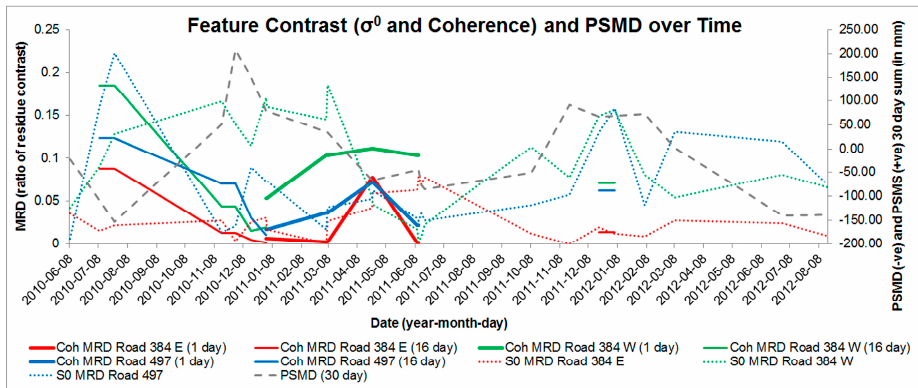
Figure 39. Graph showing clarity (contrast) of the archaeological residues in Prenestina: eastern part of Road 384 in red, western part of Road 384 in green and Road 497 in blue. Residues in the filtered σ 0 images are shown as dotted lines, in the 16-day coherence images as continuous lines, and in the 1-day coherence images as bold continuous lines. The clarity of residues is quantified as a ratio (MRD). PSMD and PSMS plotted as a grey dashed line. Negative values correspond to high PSMD (dry conditions), while positive values correspond to high PSMS (wet conditions).